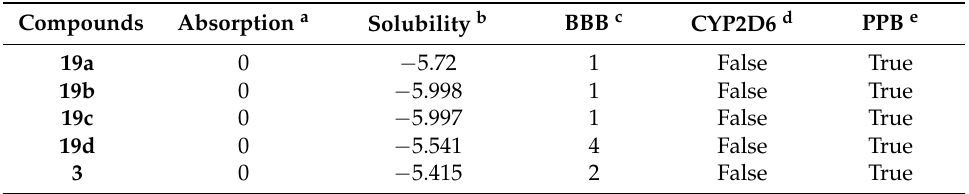
Table 3. Prediction of ADMET properties of compounds 19a – d